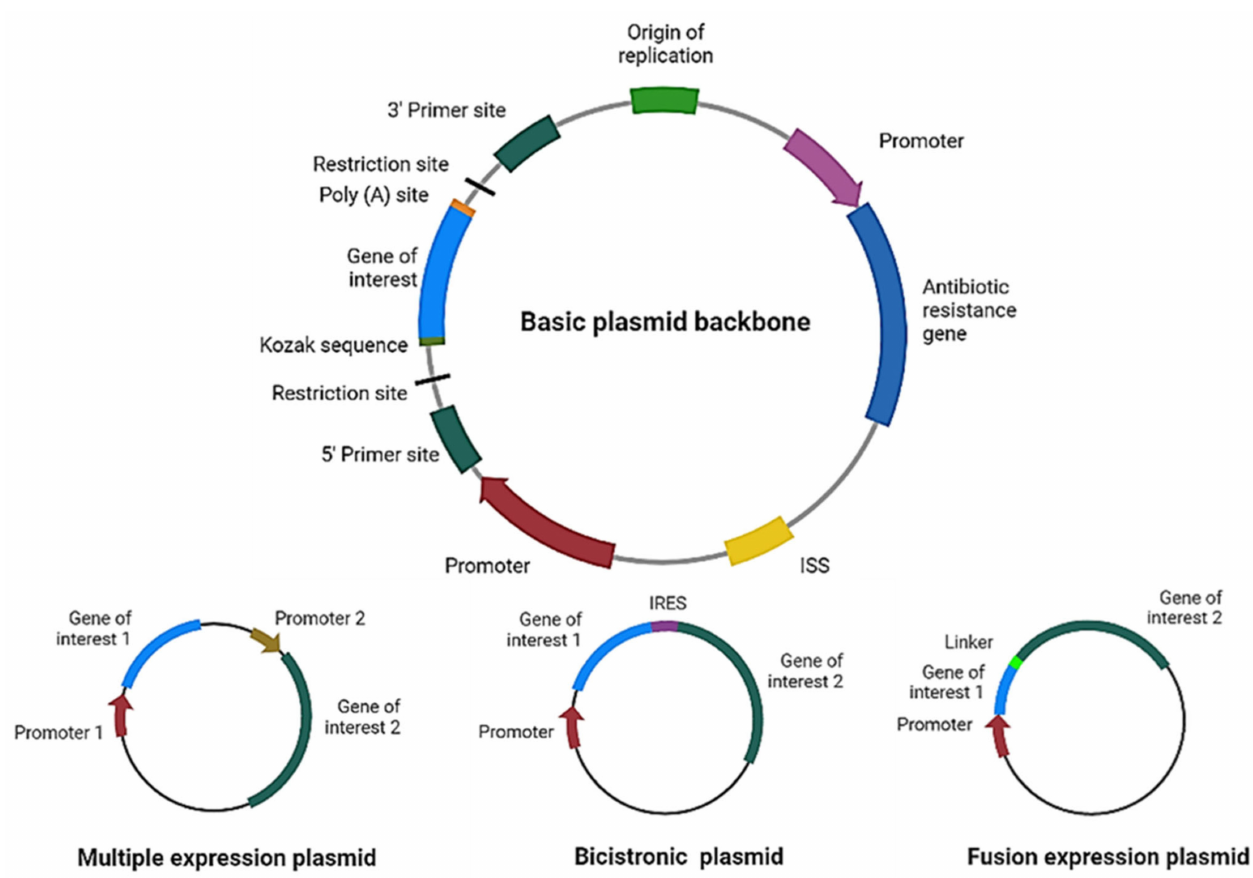
Figure 2. Plasmid design for expression of therapeutic proteins. Schematic representation of the main elements to include in a basic plasmid backbone for cancer therapy and plasmids for expression of multiple proteins. ISS: immunostimulatory sequences; IRES: internal ribosome entry site. Figure created in